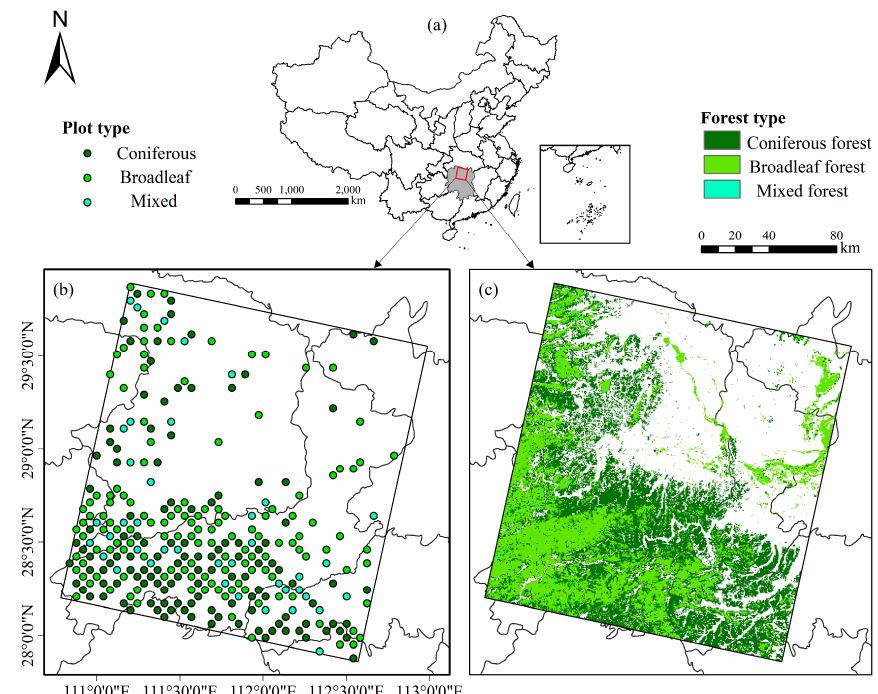
Figure 1. Study area (red box) in Hunan Province, China ( a ); the spatial distribution of sample plots ( b ); and the distribution of forest types ( c ).